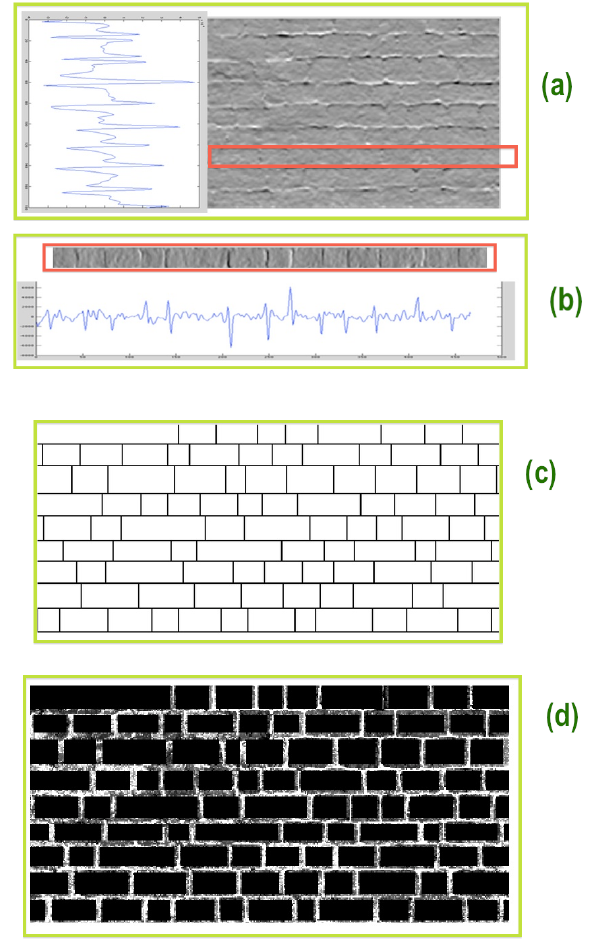
Figure 2 Definition of markers based on geometry for the watershed segmentation. a) detection of joints between masonry courses in the gradient image; b) detection of joints between adjacent ashlars for each masonry course; c) wireframe denoting the corners for the markers of each block; d) markers after